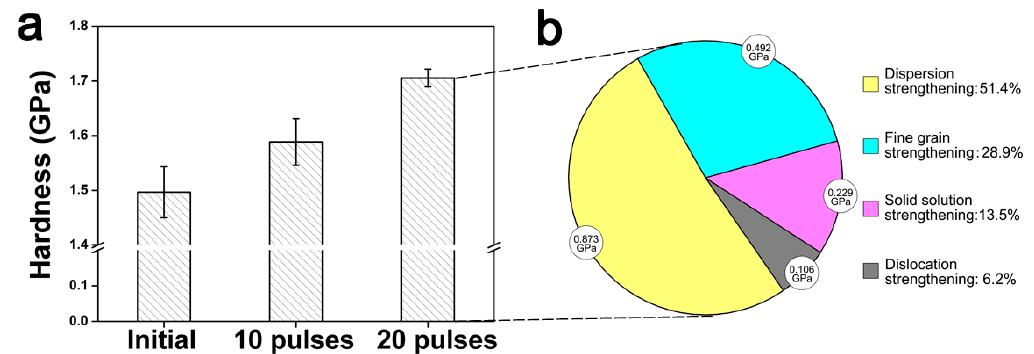
Figure 6. ( a ) Micro-hardness measurements of the initial pure Ni and HCPEB-irradiated Cr–Ni sample surfaces; ( b ) proportion of strengthening mechanisms of the 20-pulse HCPEB-irradiated Cr–Ni alloying layer.